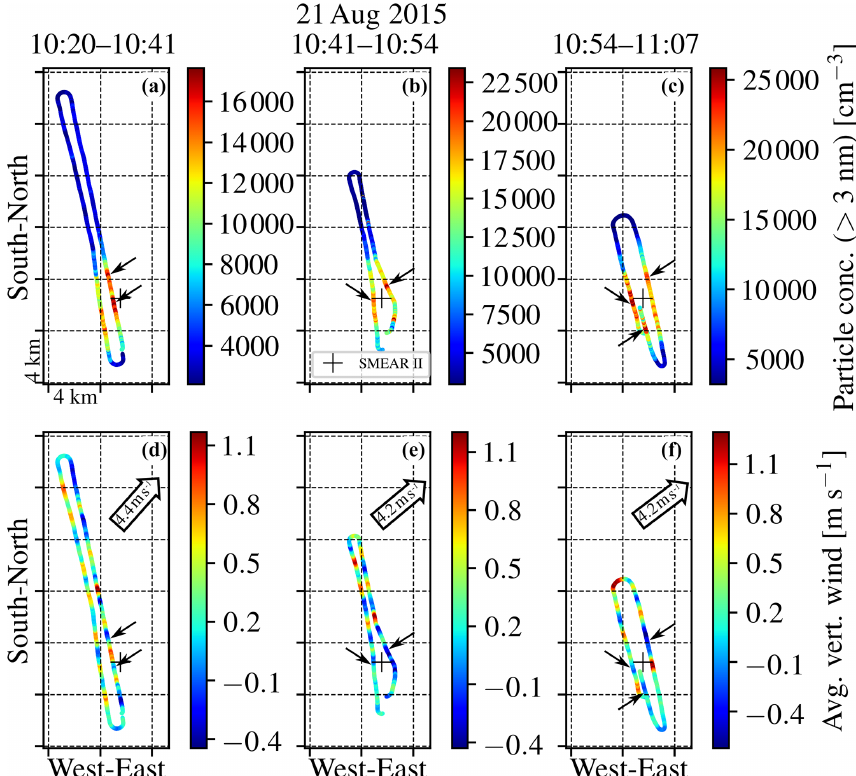
Figure 5. In (a–c) , the sections of the measurement airplane’s flight track are colored by number concentrations of particles greater than 3nm. The grids have a 4km × 4km spacing, the plus sign marks the position of the SMEAR II station, and the time intervals for the flight track sections are displayed on top of the panels. In (d–f) , the same flight tracks are colored by vertical wind speed smoothed using a 30s moving average. The positive sign refers to updraft and the negative sign to downdraft. The large arrows show the mean wind speed and direction measured on board the airplane. The flight tracks were flown inside the convective BL between 120 and 620ma . g . l . The small arrows show that the maxima in the particle number concentration were located in the roll